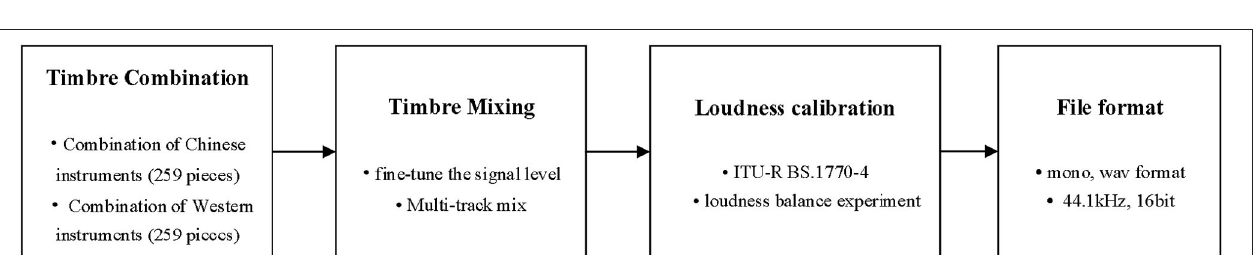
FIGURE 1 | Production of single-tone stimuli.